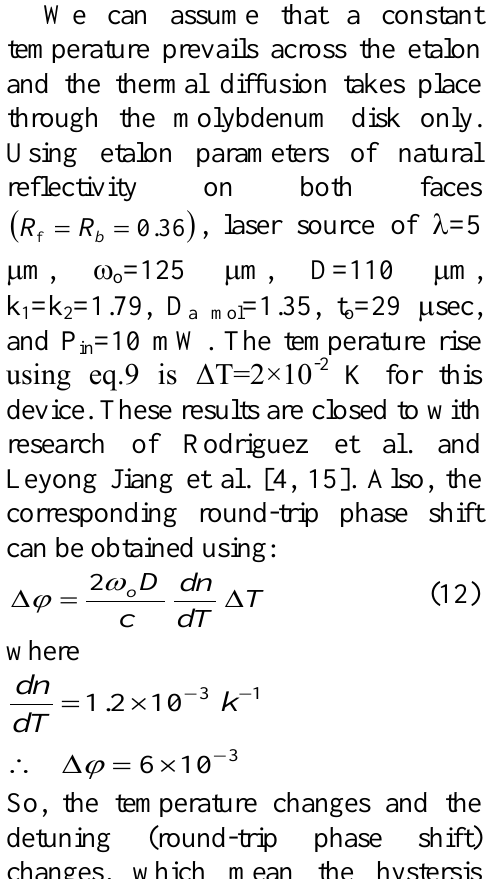
Fig.2: The detuning (round-trip phase shift) changes as a function of temperature change: (a) for constant switching time and (b) for constant incident